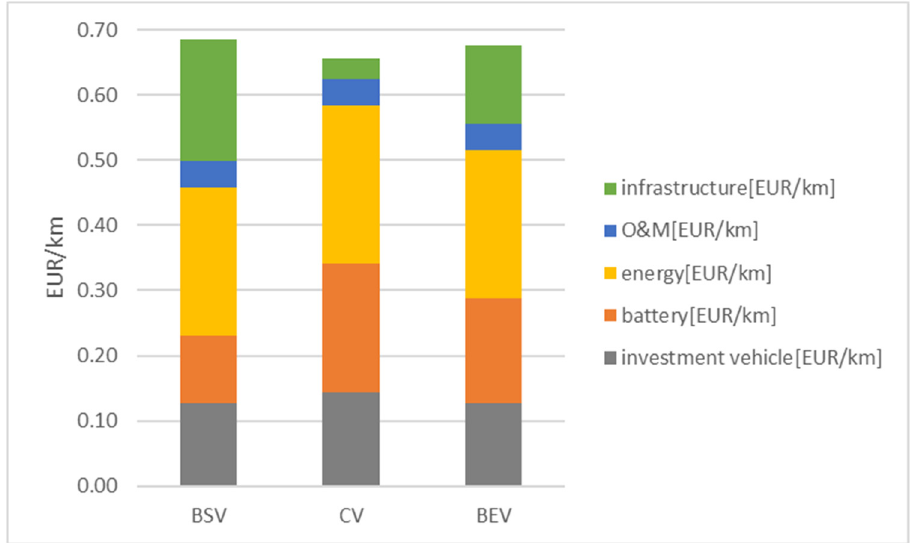
Figure 3. TCO analysis for different drivetrains 2030.